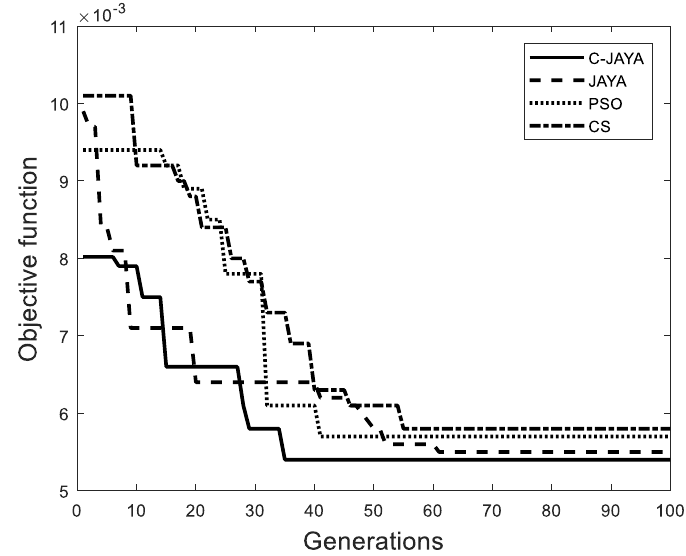
Figure 7. Objective function variation.